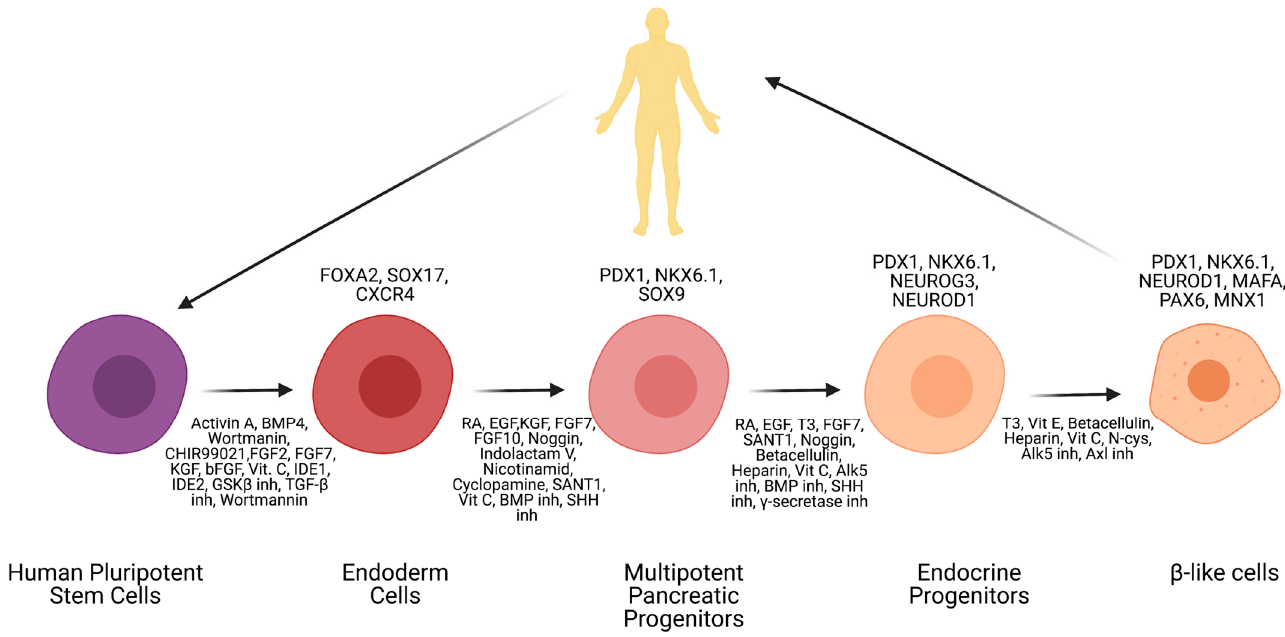
Figure 2. Schematic representation of stem cells differentiation protocol into β -like cells. Created with BioRender.com accessed on 17 June